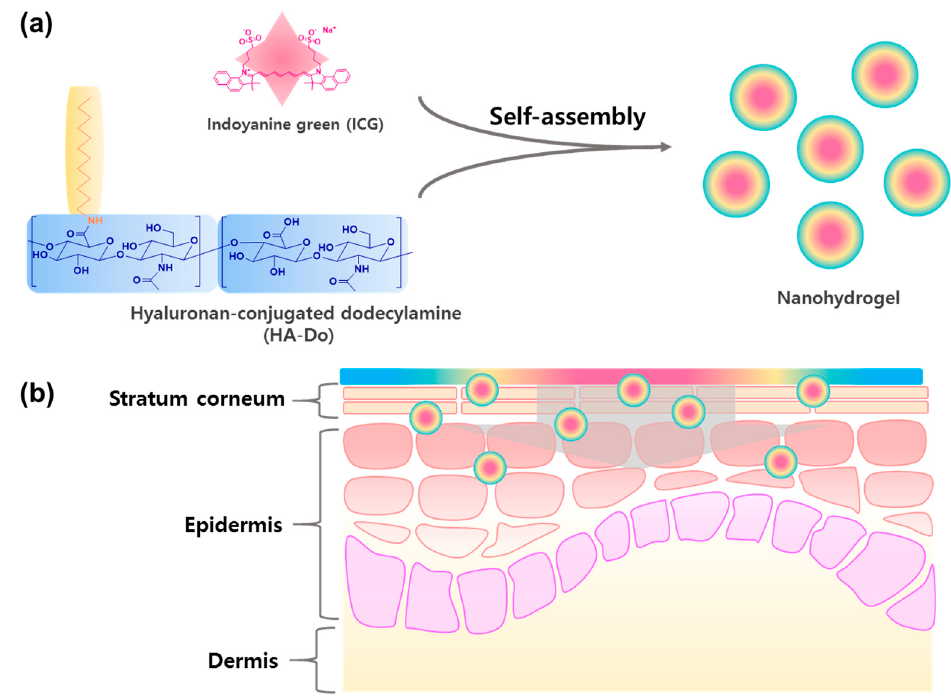
Figure 1. ( a ) Preparation of hyaluronan-based nanohydrogels using hyaluronan-conjugated dodecylamine (HA–Do) and indocyanine green (ICG), and ( b ) their applications as effective carriers for transdermal delivery.